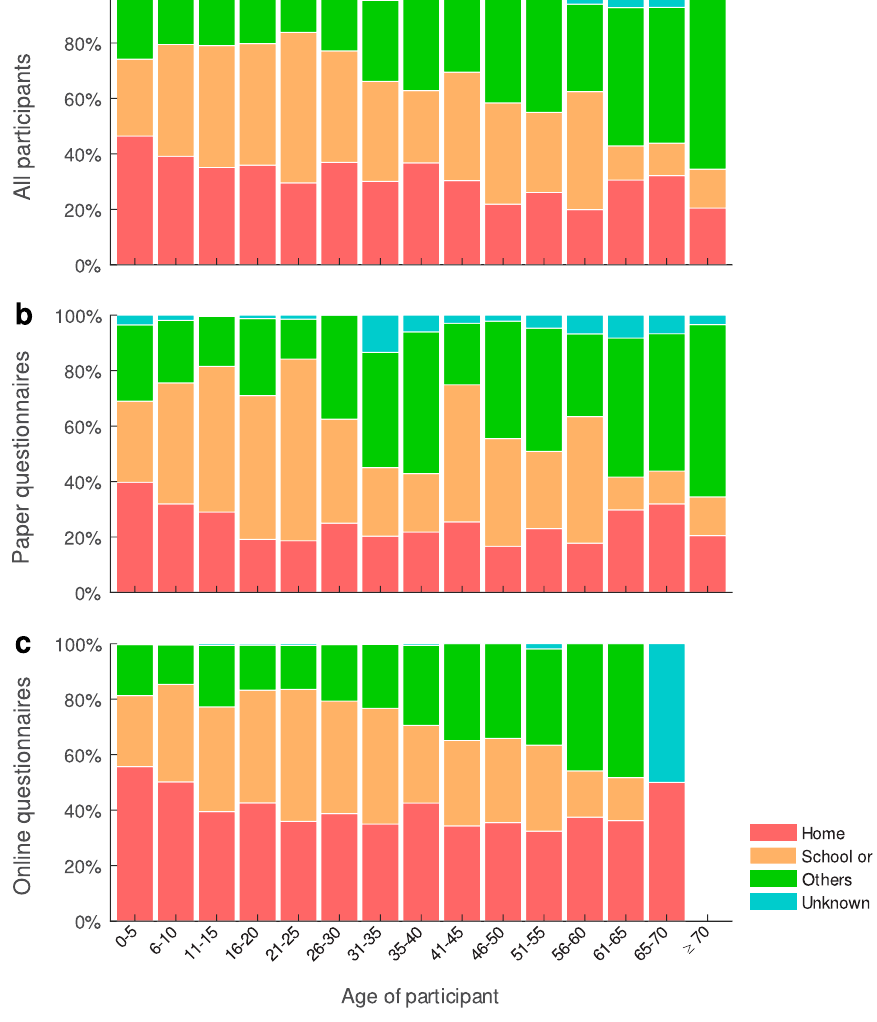
Figure 2. The relation between participants and their contacts. Participants could report the relationship with their contacts in one of the following categories: household members, classmates or schoolmates, workmates, others and unknown. ( a ) All participants. ( b ) Participants using paper questionnaires. ( c ) Participants using online